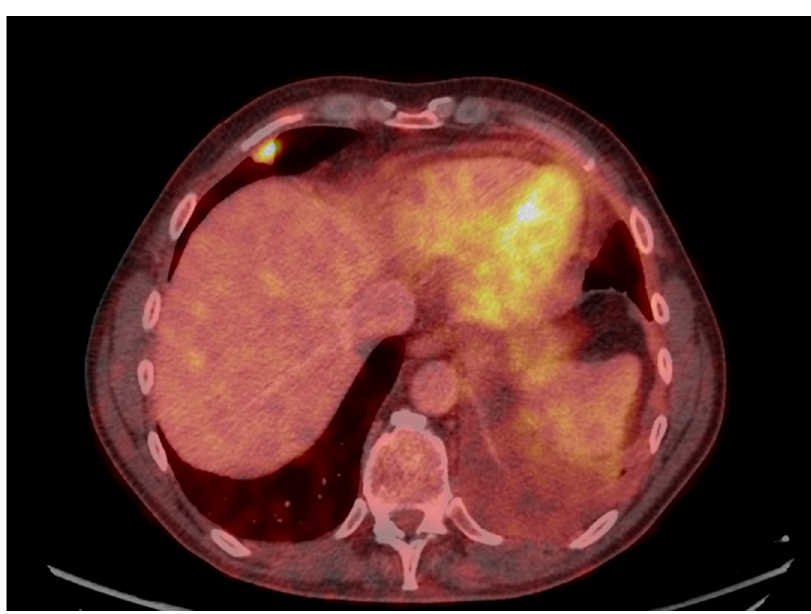
Figure 3. FDG-PET/CT showing pleural metastasis in the right lung’s middle lobe.